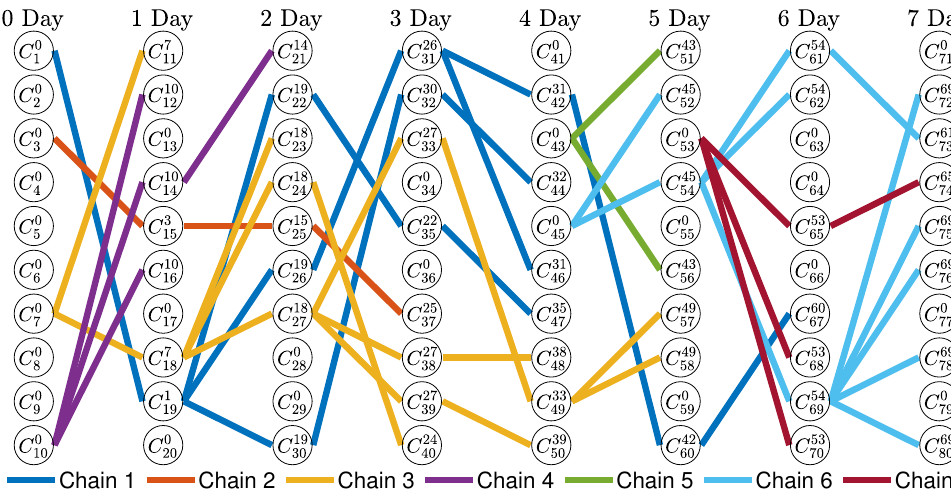
Figure 3. Infection network during 7 days. Here, C ( n ) = 10 for n = 0, 1, · · · , 7. The superscript of infected person C is the number of the parent who infected the patient C , and the subscript is the unique number of the infected person C . The number of chains is 7, and one chain is expressed with the same